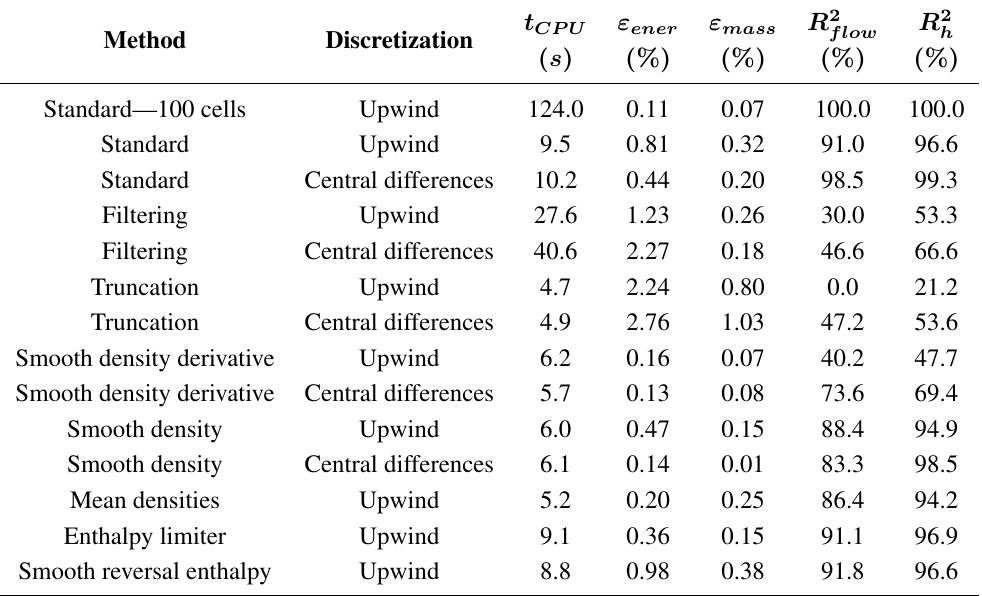
Table 2. Simulation results of the speed